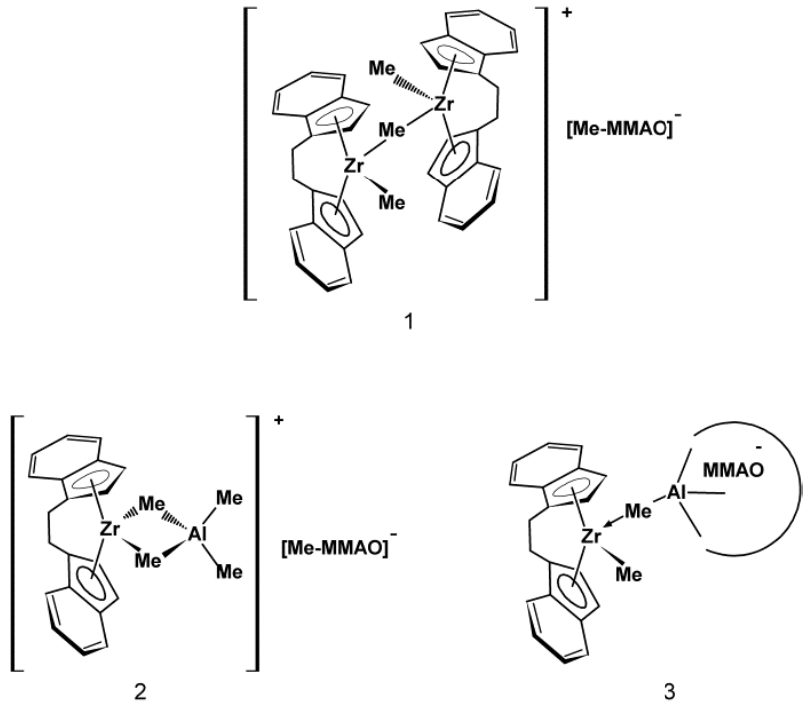
Figure 5. Proposed structures of catalytic intermediates formed within the rac -Et(Ind) 2 ZrCl 2 /MMAO catalytic system for the range of Al/Zr molar ratios used.